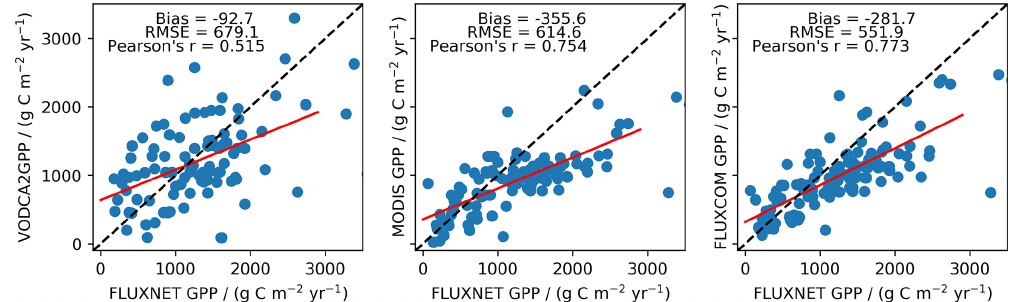
Figure A1. Mean annual in situ GPP (FLUXNET) plotted against mean annual GPP from VODCA2GPP, FLUXCOM, and MODIS for the respective grid cells. Mean annual GPP was computed from all available overlapping years, and thus each station is represented by one dot. Red lines indicate the best linear fits determined by ordinary linear regression, and the black lines represent the 1 : 1 lines.